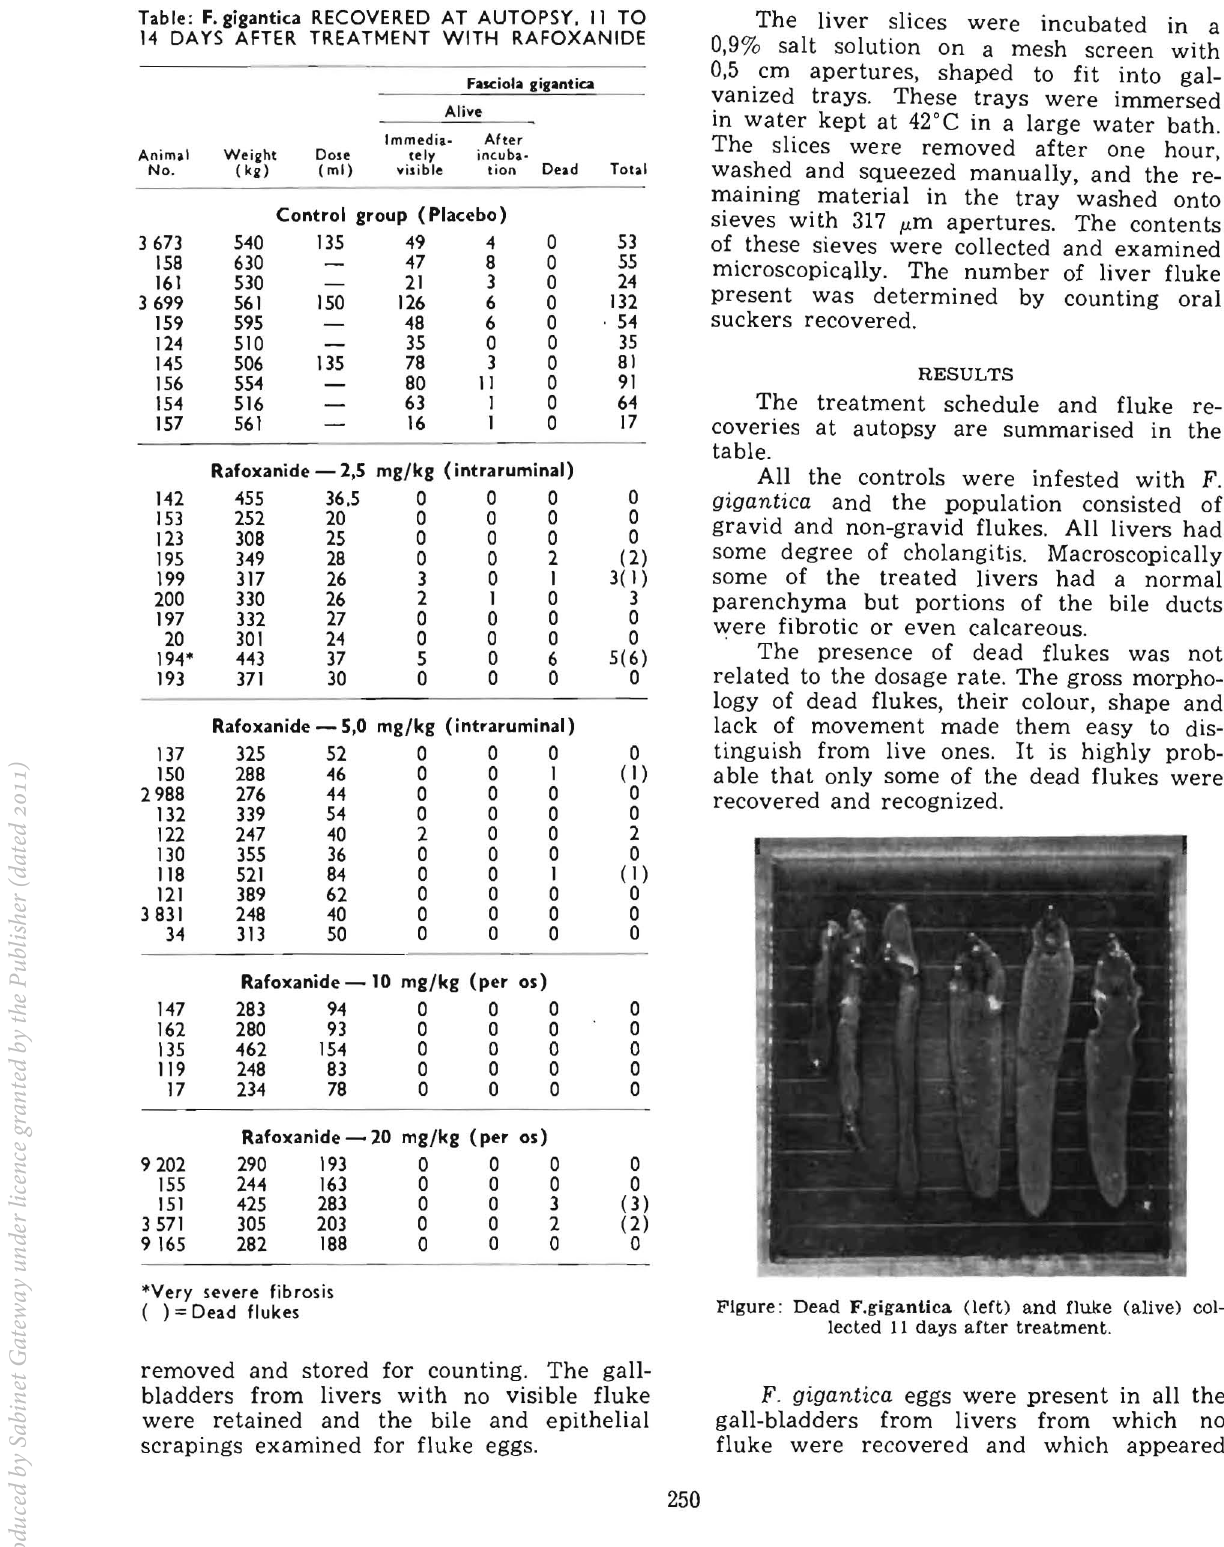
Figure: Dead F.gigantica (left) and fluke (alive) col lected 11 days after treatment. F. gigantica eggs were present in all the gall-bladders from livers from which no fluke were recovered and which